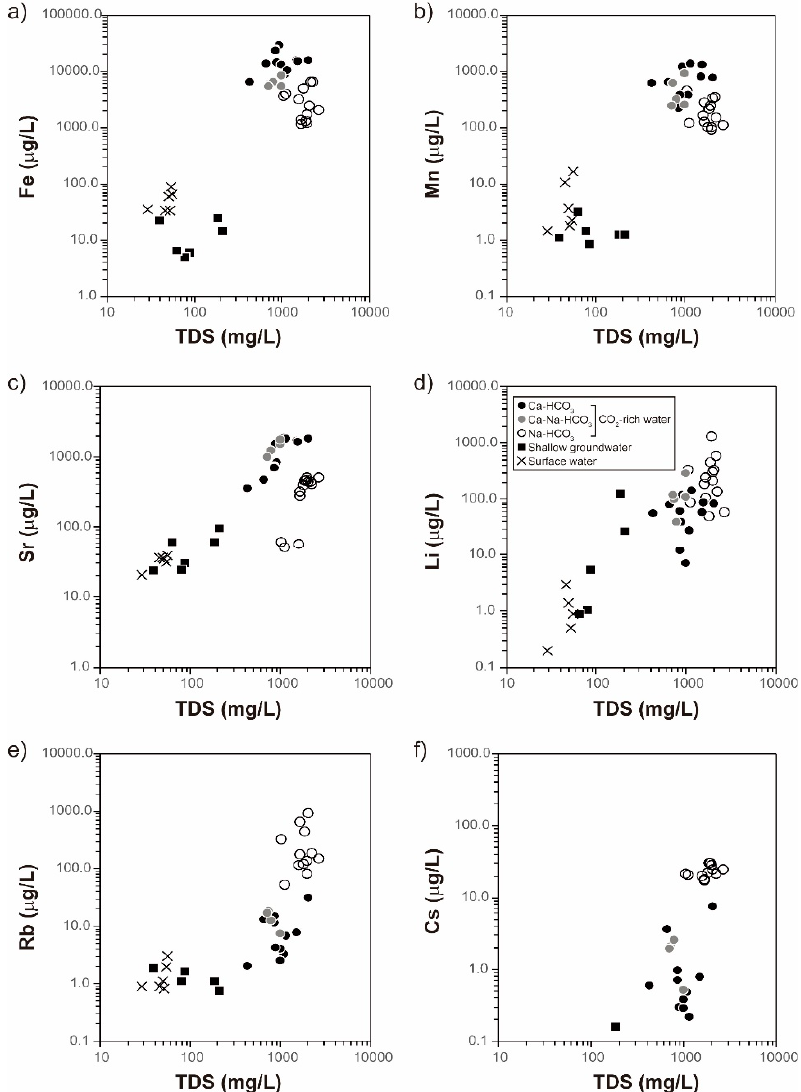
Figure 5. Plots of TDS versus trace elements for water samples: ( a ) Fe, ( b ) Mn, ( c ) Sr, ( d ) Li, ( e ) Rb and ( f ) Cs.